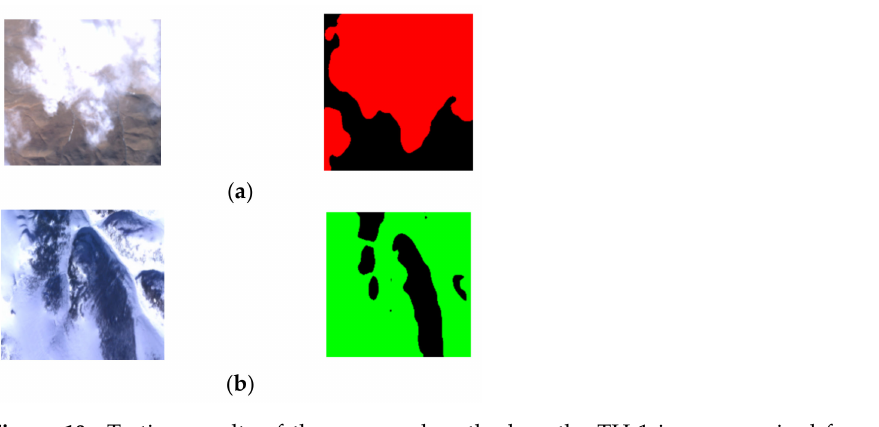
Figure 10. Testing results of the proposed method on the TH-1 image acquired from different temporal phases. ( a ) Cloud; ( b ) snow ground.